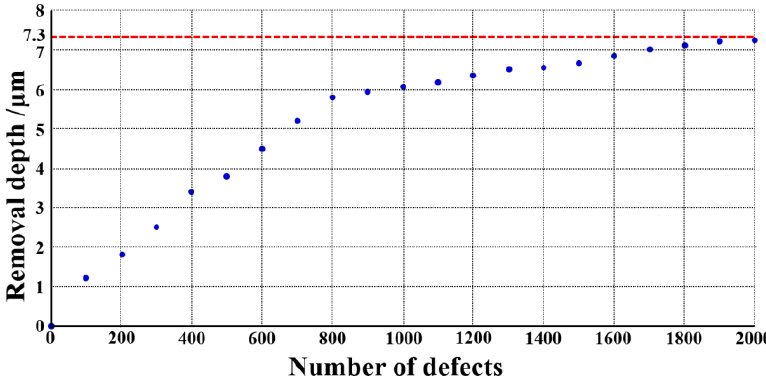
Figure 11. Predicted removal depth of different number of defects.